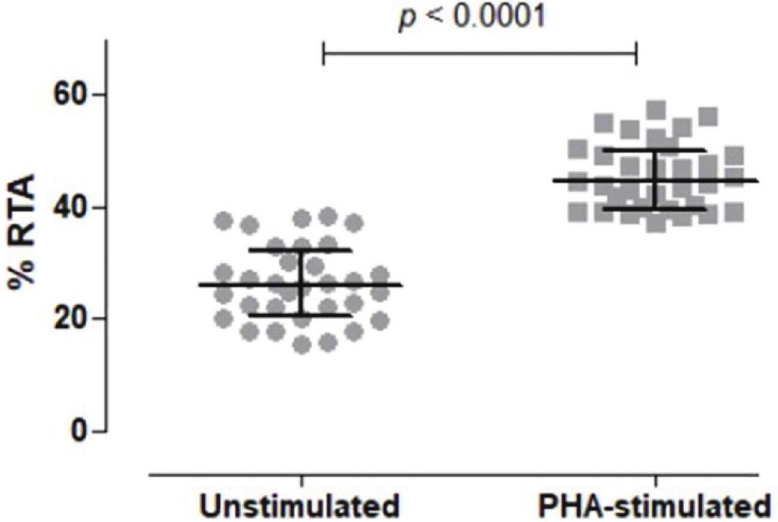
Figure 5 - Comparison of Unstimulated and PHA-stimulated Relative Telomerase Activity (RTA). Comparison of unstimulated and PHA- stimulated conditions in 32 healthy subjects using paired t-test. The mean %RTA was 26.35% for unstimulated and 45.53% for PHA- stimulated cells. The confidence interval of 95% was not shared by unstimulated (23.89–28.82) and PHA-stimulated (43.38–47.68) conditions, confirming that the data were significantly different and not